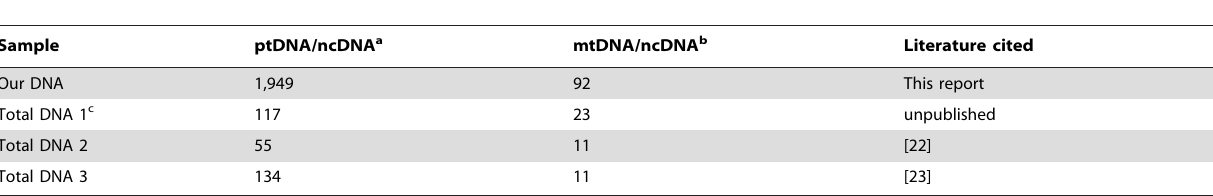
Table 5. Comparison of sequencing depth in different DNA